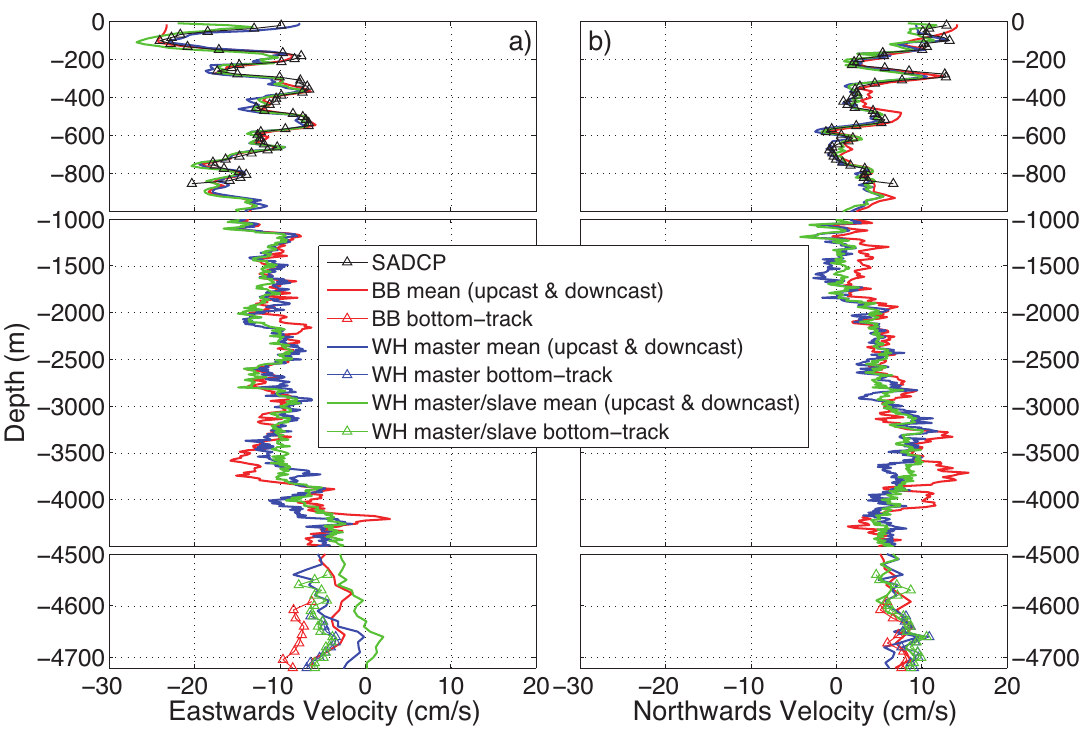
Fig . 2. – LADCP data processed using the Visbeck method at Station #23 (26.5°N, 75.9°W): a) eastwards velocity component, b) northwards velocity component. BB and WH master represent data processed individually, while WH master/slave corresponds to the combined data of the down- and up-looking WH running in master/slave mode. Note that the vertical scale is different for each depth range. Mean profiles are the average of the upcast and